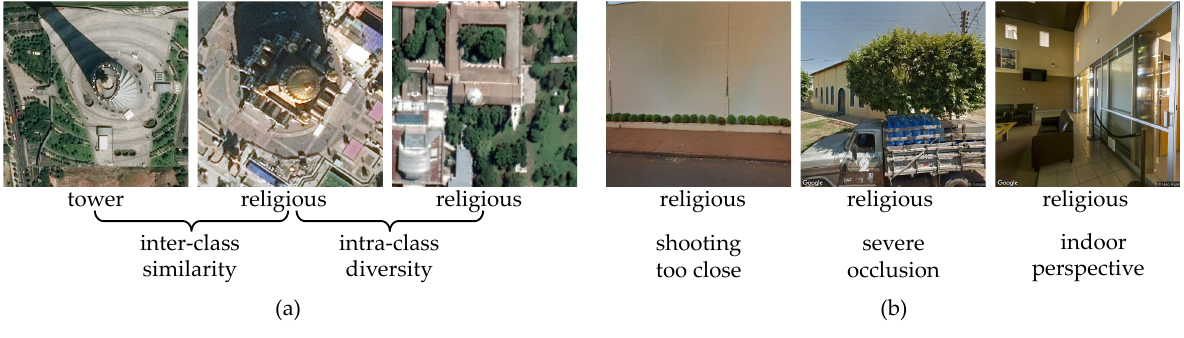
Figure 1. Different kinds of sample uncertainty in ( a ) aerial images and ( b ) ground